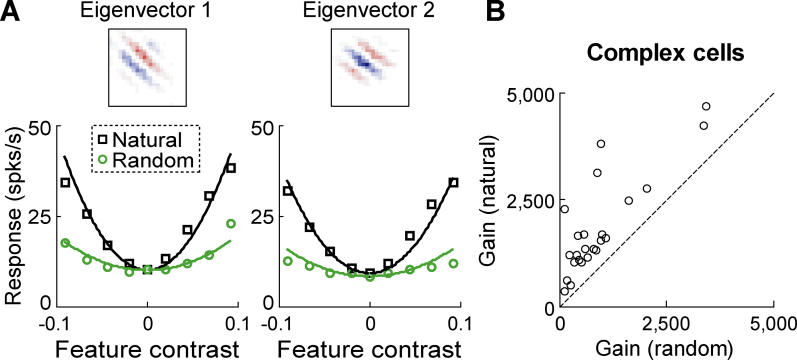
Feature Sensitivity of Complex Cells in Response to Natural Images and Random Stimuli(A) Contrast-response functions for both preferred features (insets above) of a complex cell. Curves: fits of data with quadratic functions.(B) Gain of contrast-response function (in spikes/s per unit feature contrast) for natural ensemble versus that for contrast-matched random ensemble. For this population of cells, the gain was significantly higher for the natural than for the random ensemble (n = 24, from 14 cells; p < 10−4, Wilcoxon signed rank test).